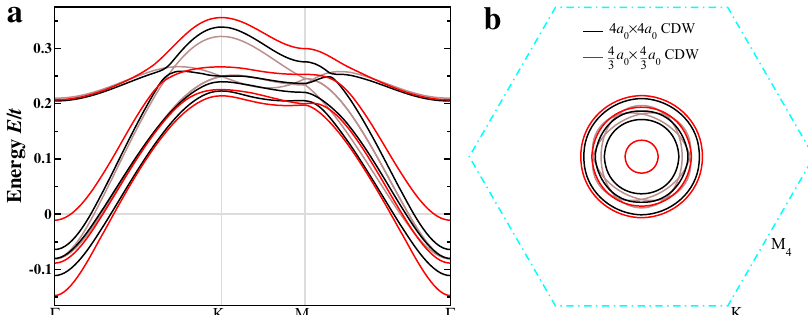
a a 4 0 × 0 CDW. Low-energybands( a )inthe4×4reducedBZ 3 3